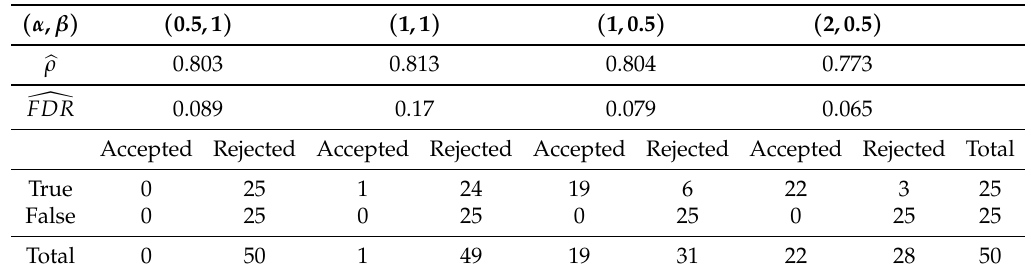
Table 2. Results for the model with Gaussian copulas and for data corresponding to 50% of true null hypotheses to distinct values of the prior distributions of p i .